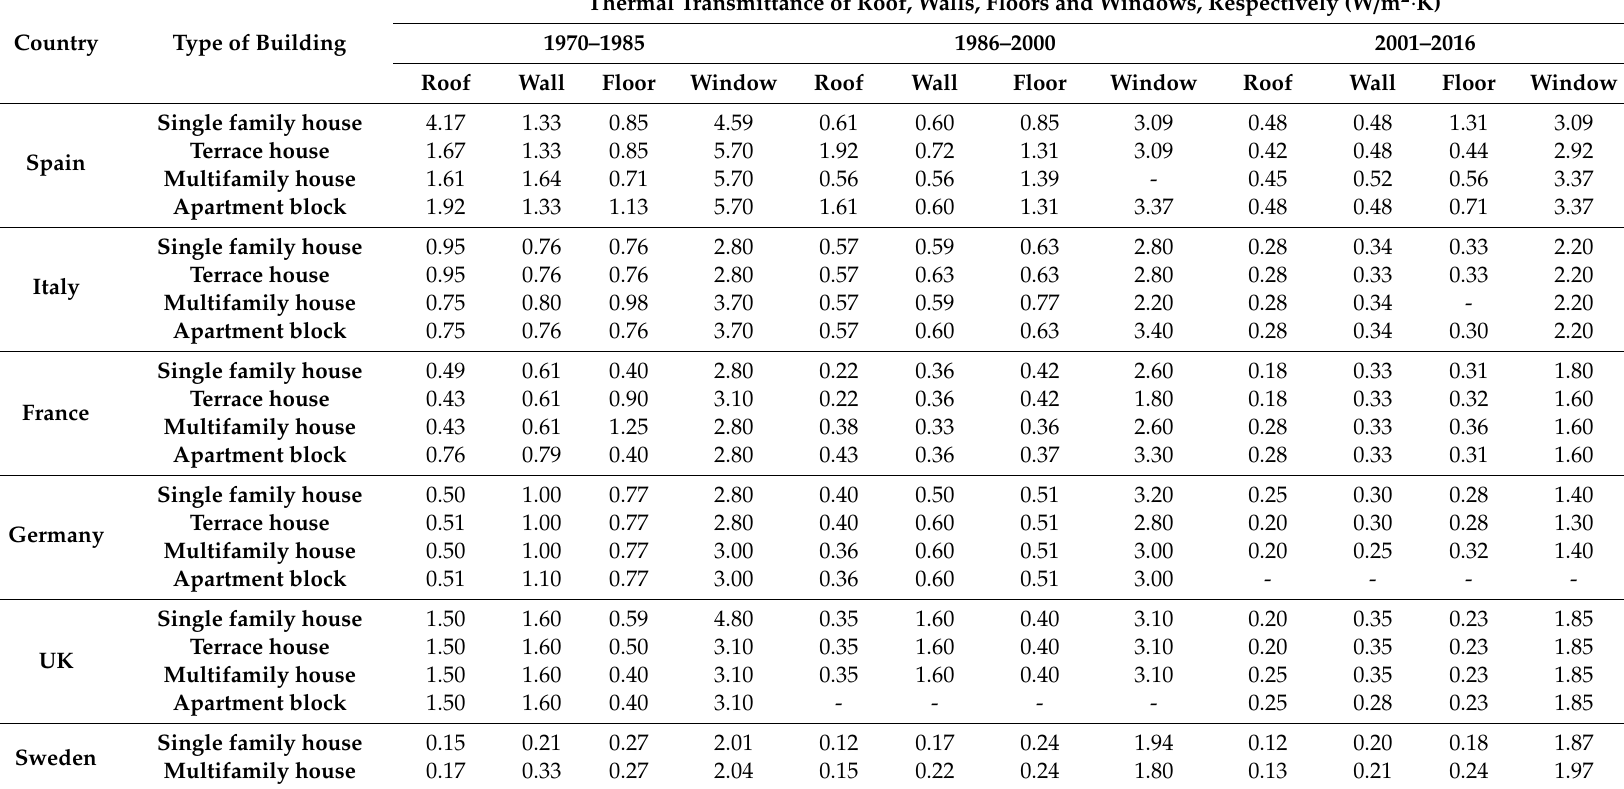
Table 1. Thermal transmittance values of the building envelope components (roof, walls, floors and windows) for the di ff erent exemplary buildings (Single-family house, terraced house, multi-family house and apartment block) selected by